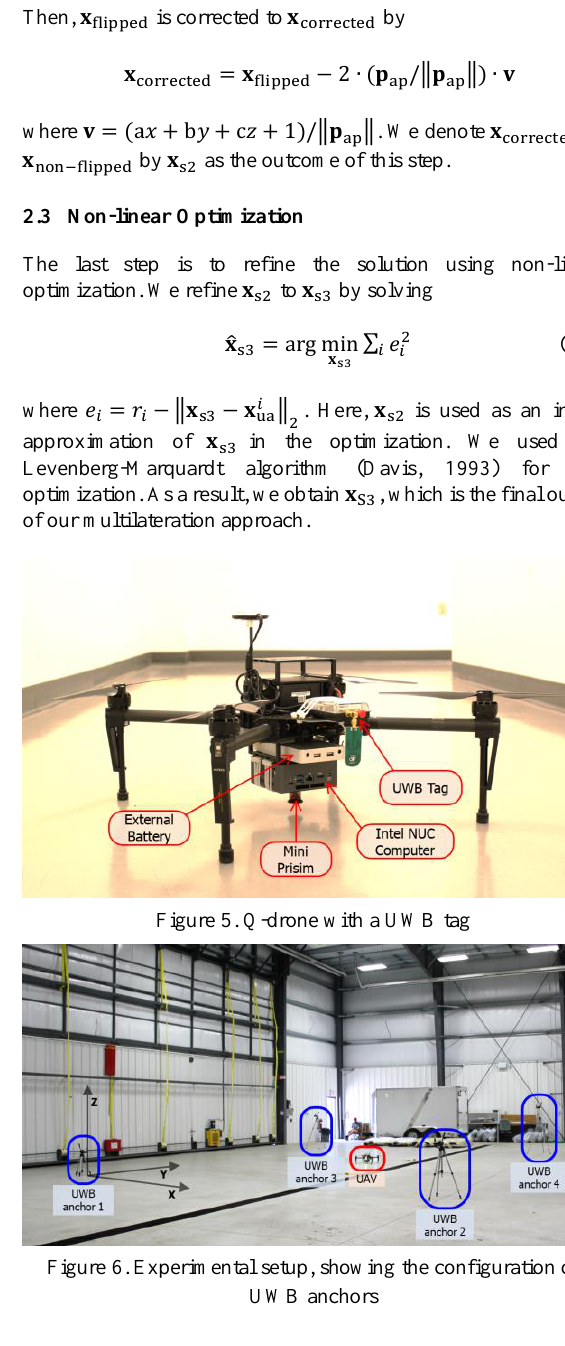
Figure 4. Symmetric reflection of a flipped solution through anchor plane